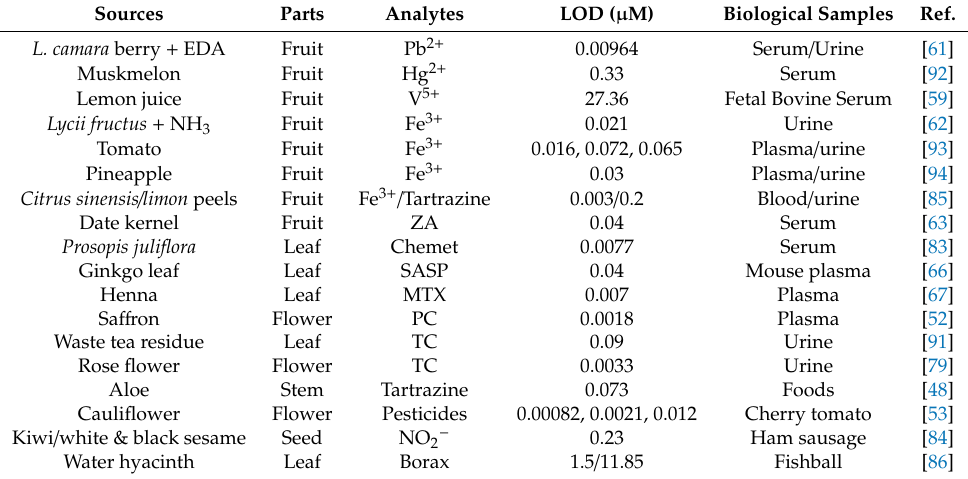
Table 5. The applications of plant part-derived CDs for the sensing of various molecules in biological